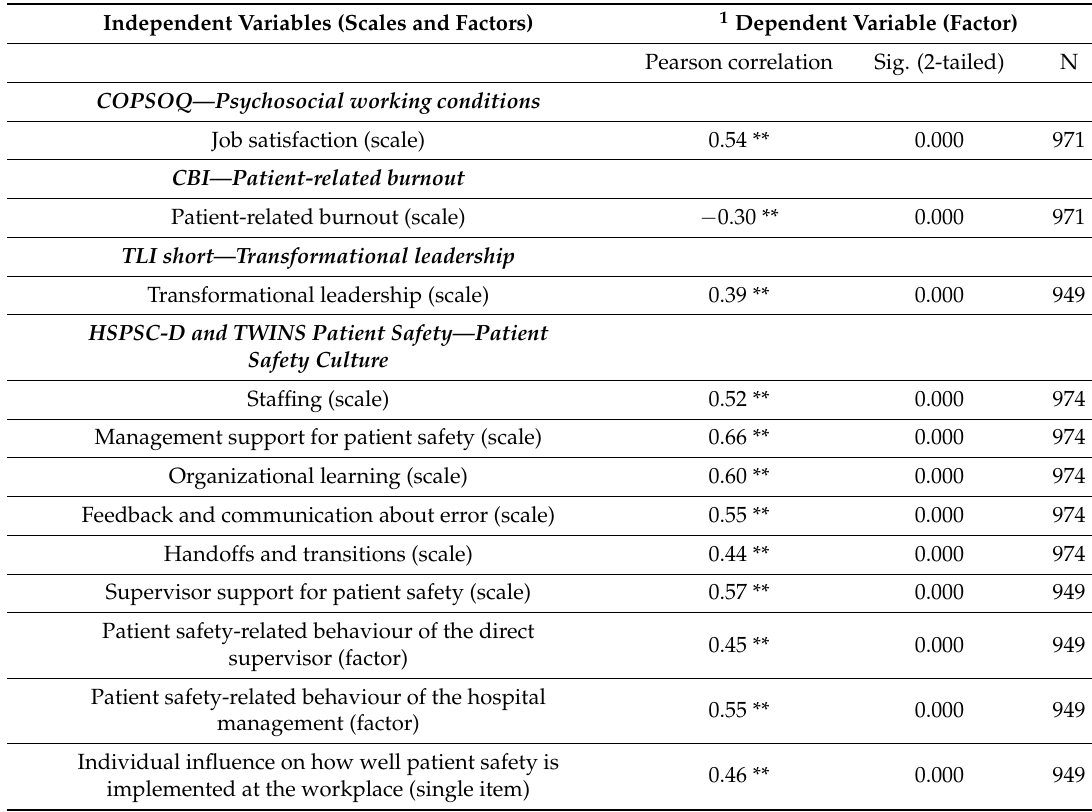
Table 6. Patient Safety Culture model—Correlations of independent variables and the outcome “perceived patient